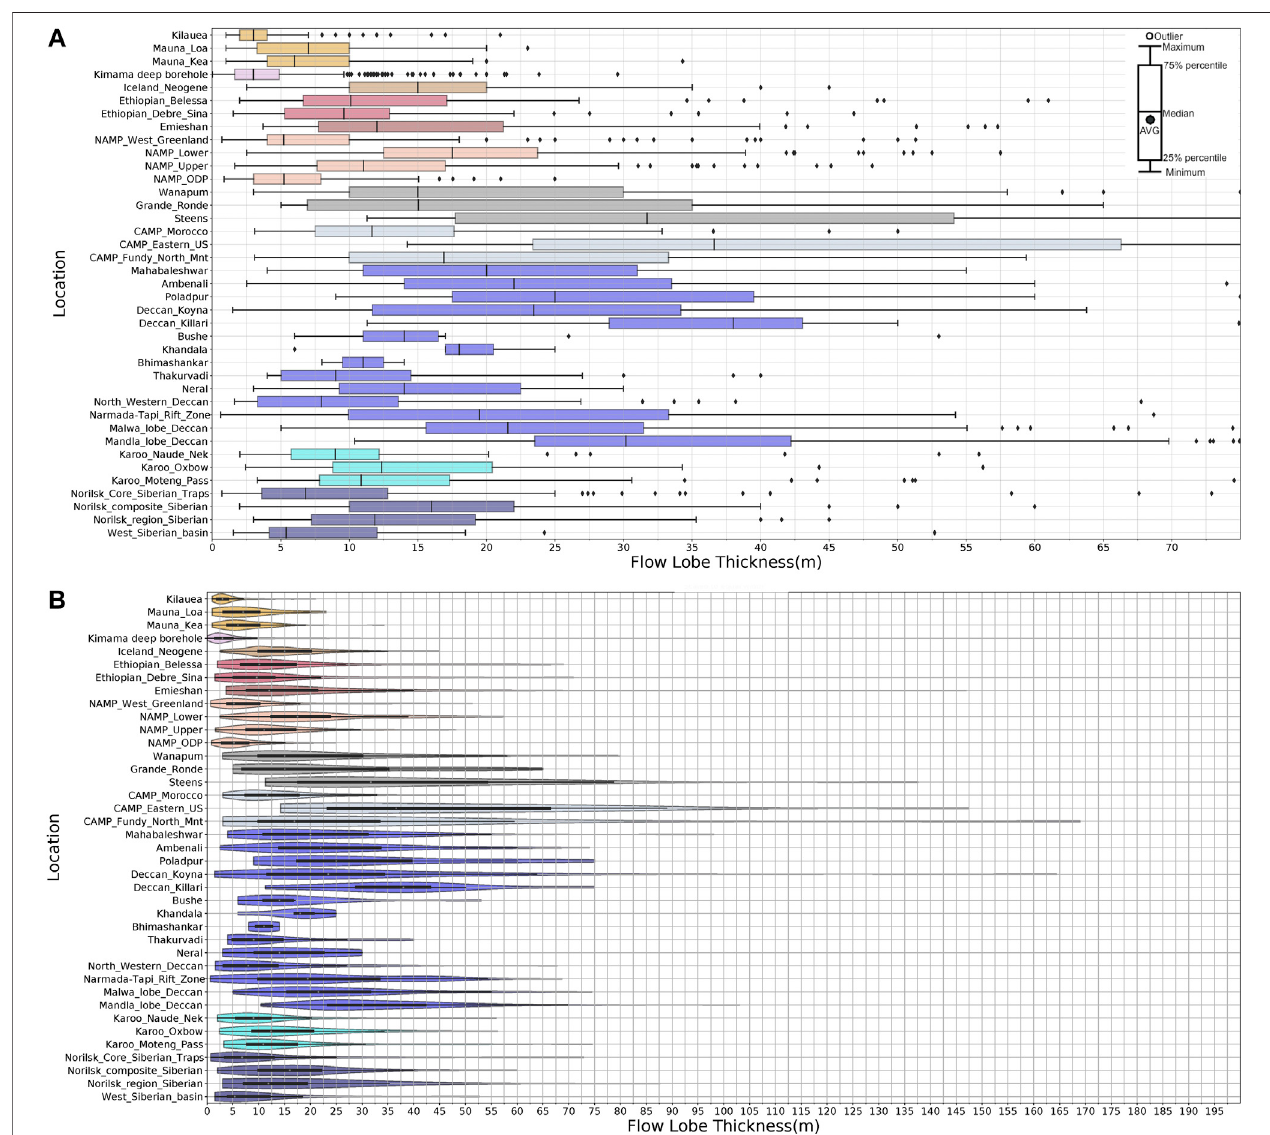
FIGURE11|(A) Boxplotoflobethicknesses invarious CFBprovinces,formations,and volcanoesforwhichdata isavailablevs thickness oflobes.CFBprovinces color-coded so that formations of each province have same color (and same colors as Figure 12 ). Bar in box is median (50th percentile); ends of box are 25th and 75th percentile;whiskerendsare5thand95thpercentile,anddotsareoutlyingthicknessesofwholelobethicknessdistributionforeachentry.Datacutoffat75 mthickness; see (B) for whole range. (B) Violin plot of lobe thicknesses in various CFB provinces, formations, and volcanoes for which data is available vs thickness of lobes. Violins scaled to equal width so that total ranges more easily seen; as (A) for colors. White dot inside violin is median (50th percentile); ends of box are 25th and 75th percentile; line ends are 5th and 95th percentile; rest of violin encloses all data of whole lobe thickness distribution for each entry.